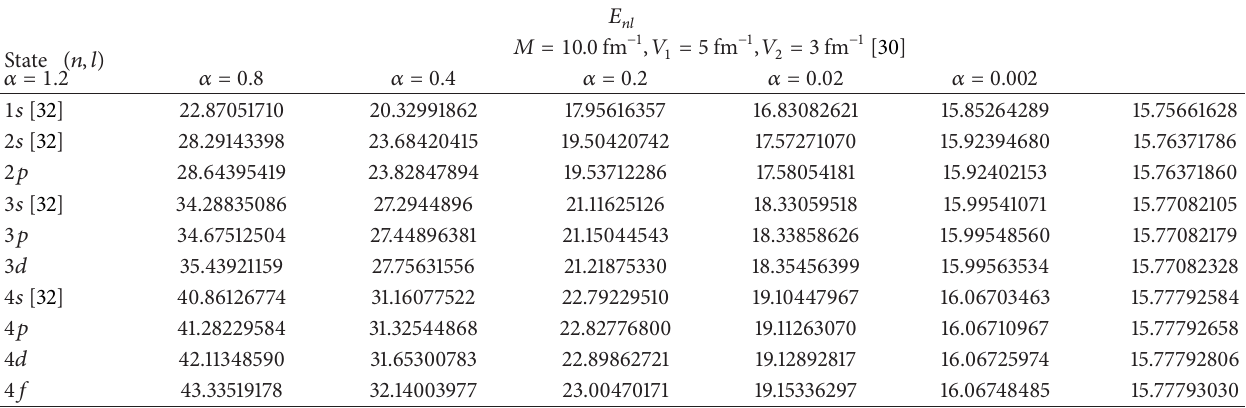
Table 6: The bound state energy levels 𝐸 𝑛𝑙 of the Schr¨odinger equation for the tPT